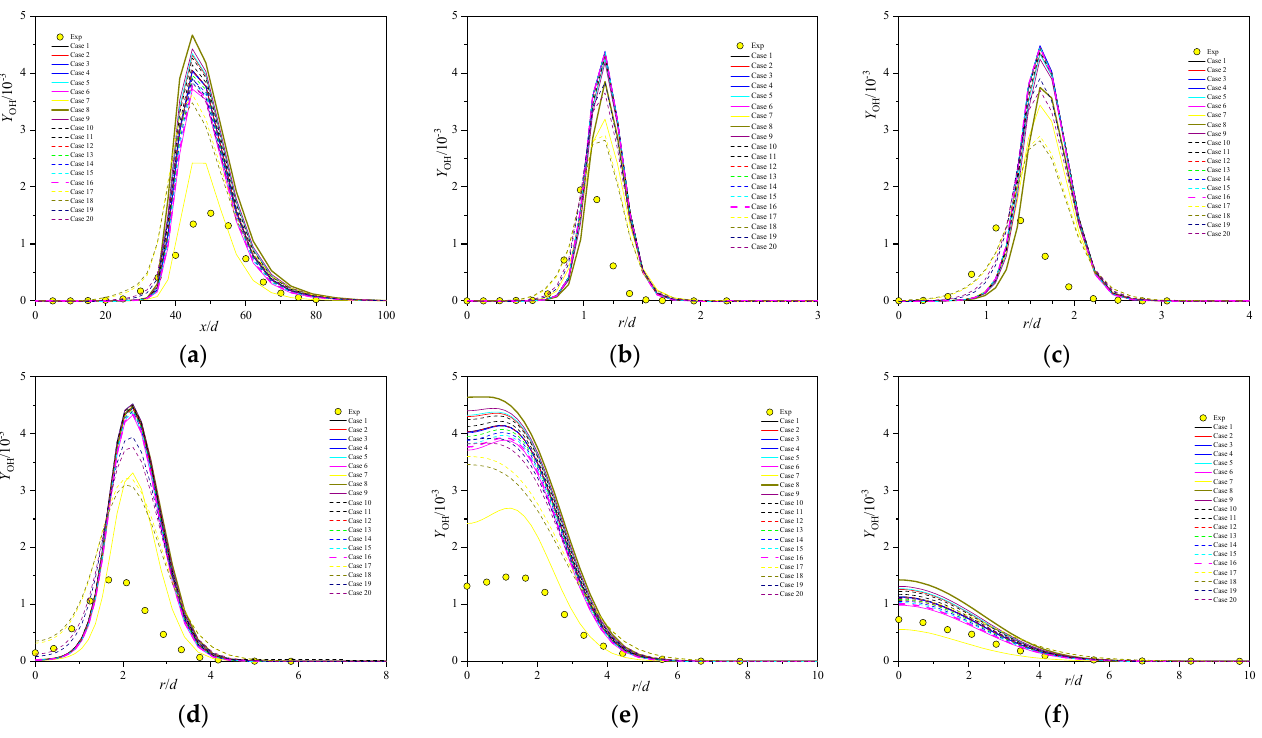
Figure 14. Comparison of measured [22,24] and predicted mean OH mass fraction profiles for the Sandia Flame D with 20 combinations of the primary EDC constants C D1 and C D2 . ( a ) @axis. ( b ) @ x / d = 7.5. ( c ) @ x / d = 15. ( d ) @ x / d = 30. ( e ) @ x / d = 45. ( f ) @ x / d =